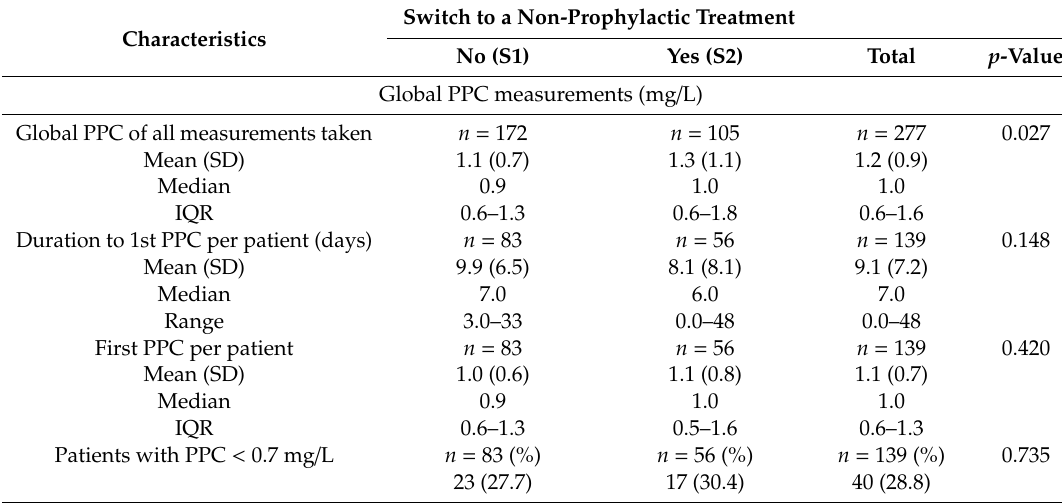
Table 4. Posaconazole therapeutic drug monitoring during the